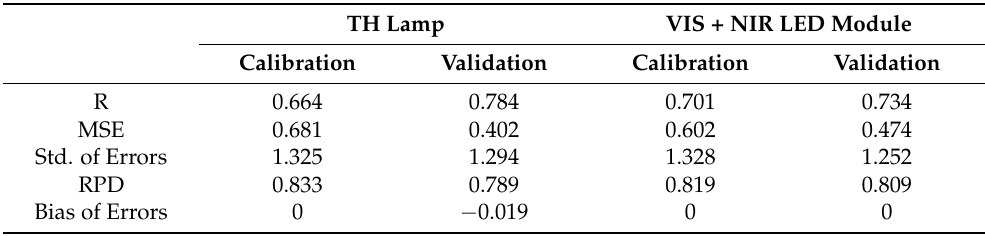
Table 1. R, MSE, Std. of Error, RPD, and Bias for PLS calibration, and validation of Fuji apple SSC prediction under TH lamp, and the VIS + NIR LED